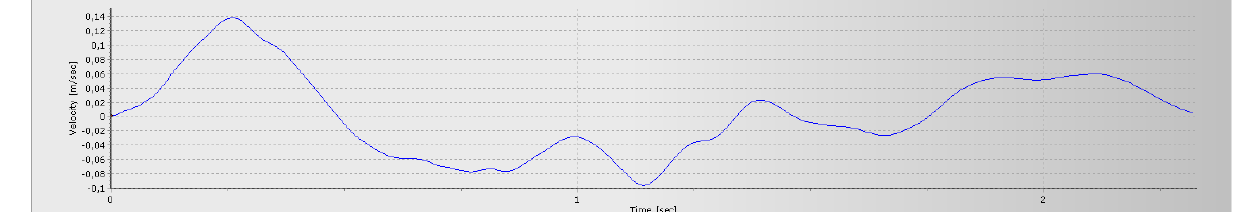
Figure 7. Velocity.